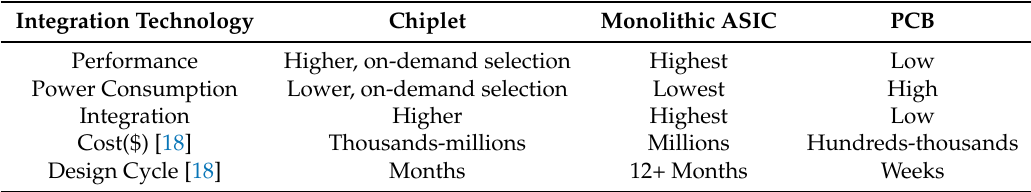
Table 1. Comparisons between Chiplet Technology and Traditional Chip Integration Technologies.